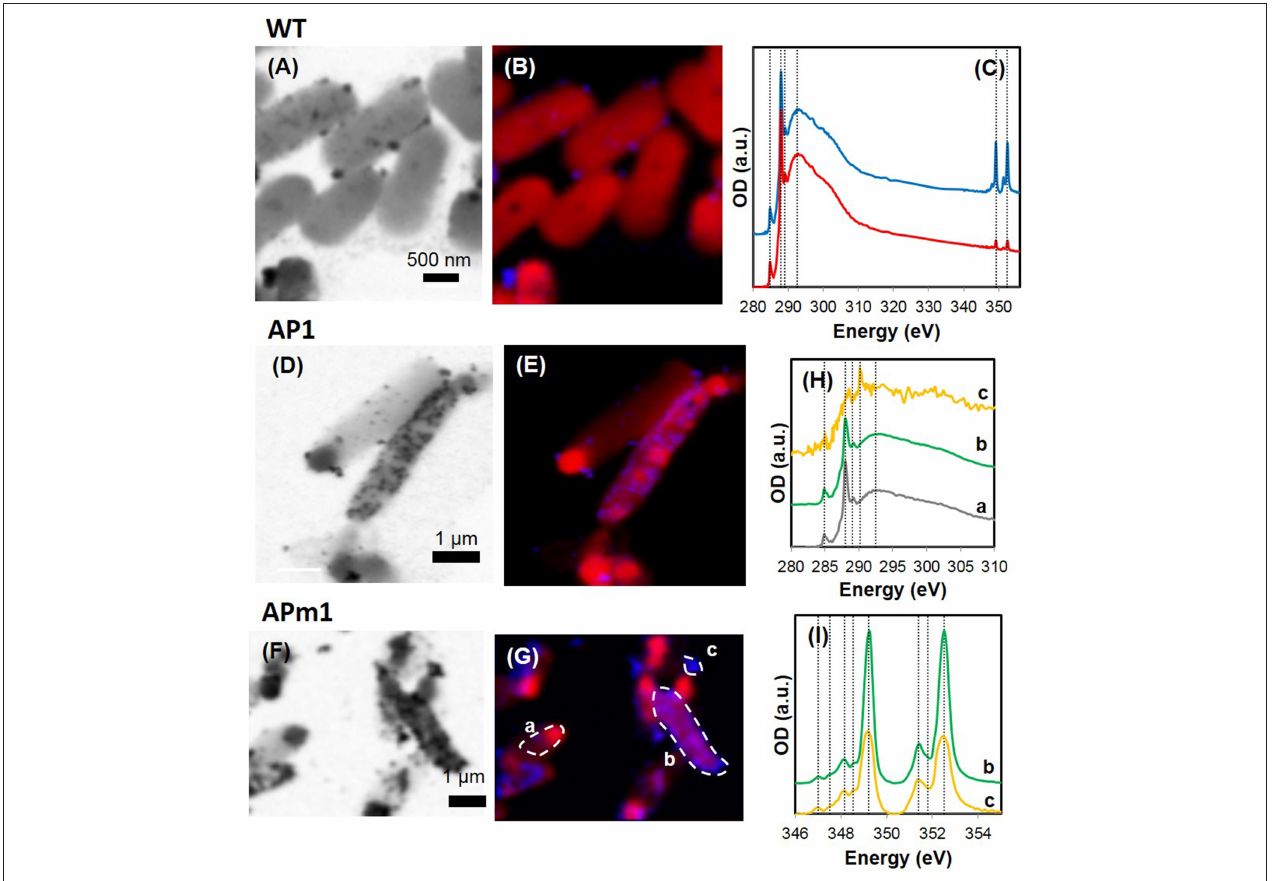
FIGURE 5 | STXM analyses of WT, AP1, and APm1 E. coli during the calcification experiments. (A–C) WT E. coli after 24 h in the calcification medium. (A) Image at 349eV. (B) Map of organic C (red) and Ca (blue) obtained on the same area as (A) . XANES spectra at the C K and Ca L 2 , 3 -edges obtained on the cells (red) and on the particles at the surface of the cells (blue). The spectrum of the precipitates at the Ca L 2 , 3 -edge is shown in greater detail in SM 1. (D,E) AP1 after 7 h in the calcification medium. (D) Image at 349.2eV. (E) Map of Ca (in blue) and organic C (in red) obtained on the same area as (E) . (F,G) APm1 after 7 h in the calcification medium. (F) Image at 349.2eV. (G) Map of Ca (in blue) and organic C (in red) obtained on the same area as (F) . (H) XANES spectra at the C K-edge, obtained on the areas depicted on (F) . XANES signal at the C K-edge is similar for non-calcified cells (a) and calcified cells (b), with peaks corresponding to organic C functional groups at 284.9, 288.1, 289.1, and 292.5eV. The signal of extracellular Ca-phosphate precipitates (c) is much noisier, due to a smaller total C concentration. A peak at 290.2eV is present corresponding to 1s → π * transitions in carbonate groups. (I) XANES spectra at the Ca L 2 , 3 -edges obtained on area (b) (calcified cell) and (c) (extracellular precipitate). Vertical positions correspond to peak energy positions in the reference HA spectrum (see Supplementary Figure